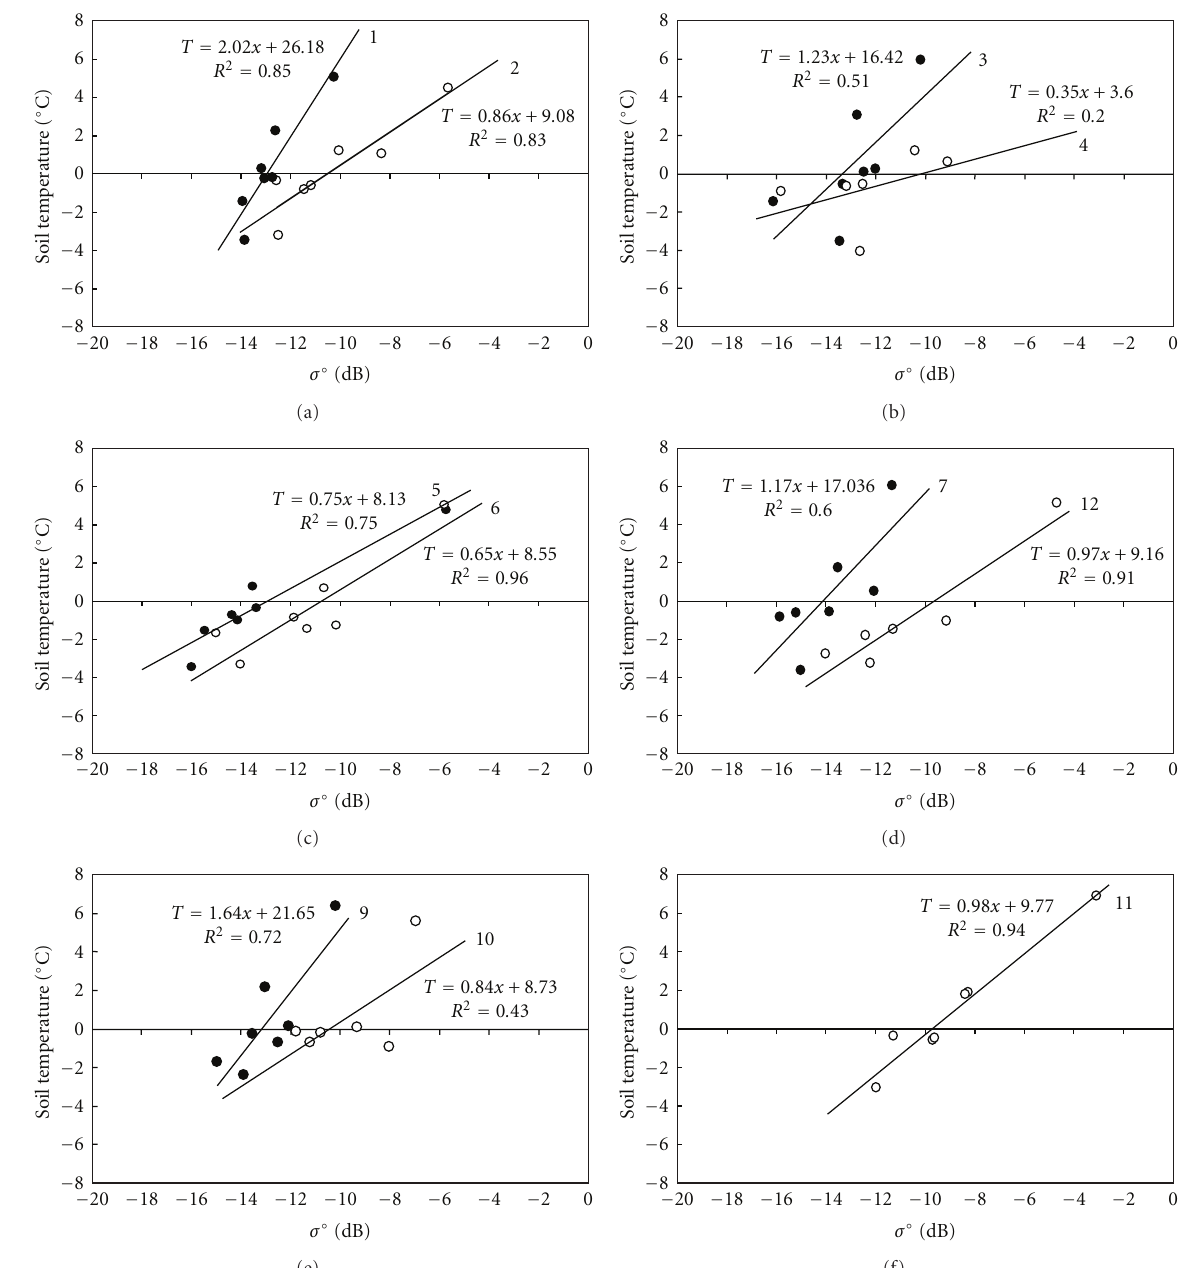
Figure 6: Linear regression models describing the variation of soil temperature measured at 5 cm in relation to the backscattering coe ffi cient, σ ◦ , according to soil type: (a) Mawcook, sandy loam, (b) Le Bras, loam, (c) Neubois, loam, (d) Beaurivage, sandy loam, (e) Woodbridge, loam, (f) organic soil, and land use type; tilled fields ( (cid:6) ) and untilled fields ( • ).